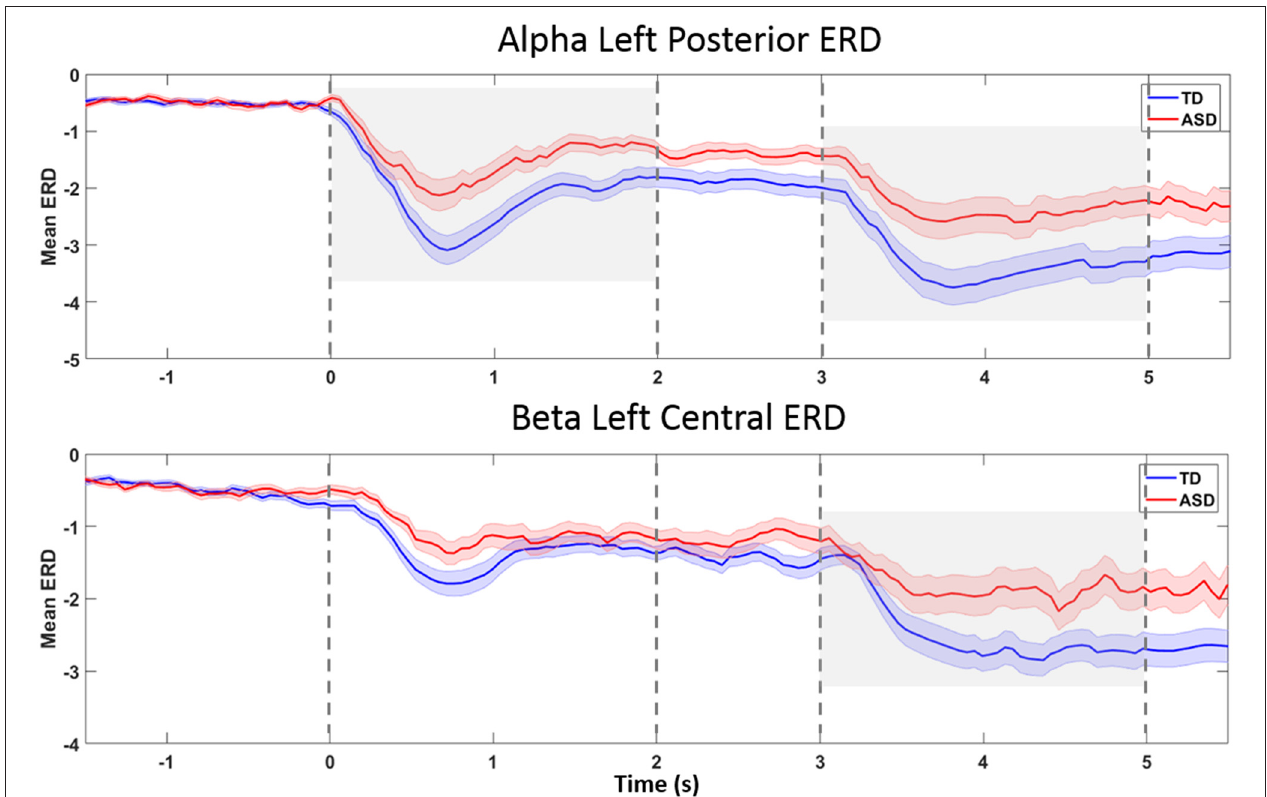
FIGURE 5 | ERD-over-time, in topographies and bands found to be different between groups. The x- axis reflects time (in seconds), and the y -axis represents ERD magnitude (in unitless z- scores). The grand average for the TD group is plotted in blue, and the grand average for the HFA group is plotted in red. Shaded areas around the mean (heavy line) represent standard errors. The Prepare phase ERD measurement in statistical calculations is the average from 0 to 2 s on the x- axis, and the Go phase, from 3 to 5 s. Plot A represents left posterior alpha ERD. Group differences were seen during both the Prepare and Go phases (gray shaded areas). In left central beta ERD (Plot B), the Go phase ERD was significantly different between groups (gray shaded area). The plots suggest that a delay in onset of ERD or temporal dispersion is unlikely to explain group differences in average